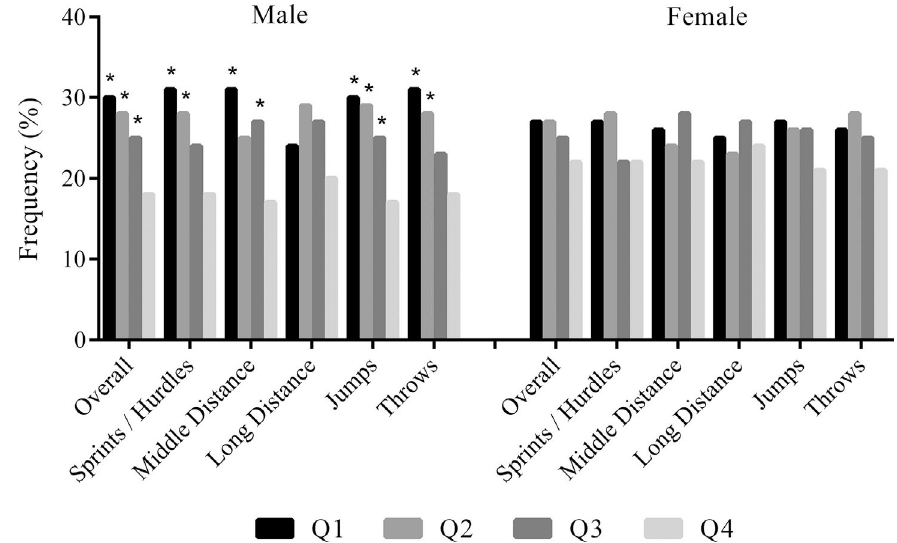
Figure 1 - Brazilian track and field athletes’ quarters of birth organized by sex and event type. * means different